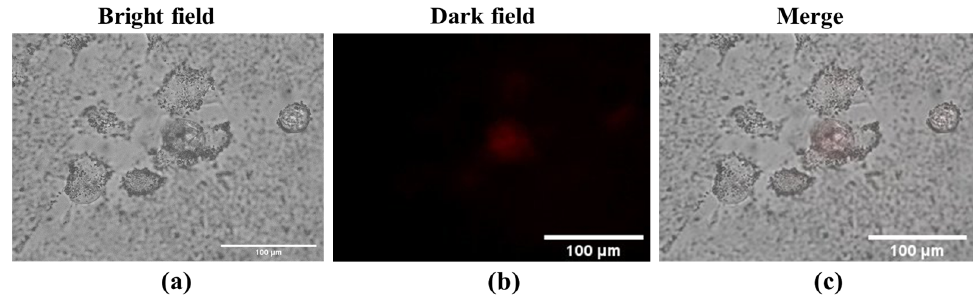
Figure 5. Fluorescence images of HEK-293A embryonic kidney cells after incubated with YVO 4 :Eu 3+ @silica-NH-GDA-IgG bio-nanocomplexes with different detection modes: ( a )—negative control, ( b )—Dark field, ( c control, ( b )—Dark field, ( c )—Merge.